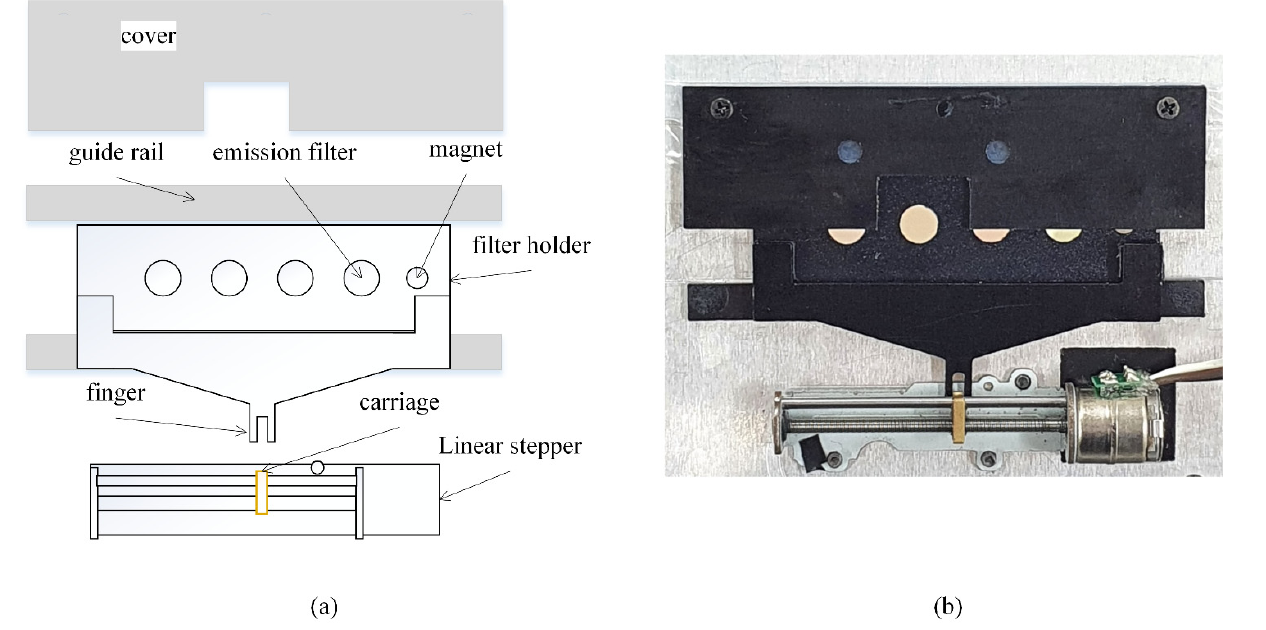
Figure 4. Emission unit. ( a ) Components of emission unit; ( b ) Assembled emission unit. Fluorescence detection starts at the end of each annealing step of the PCR cycle, ac-